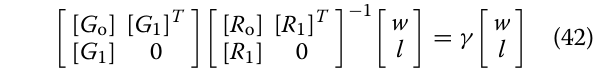
Fig. 4 Deflection of clamped–simply supported non-prismatic